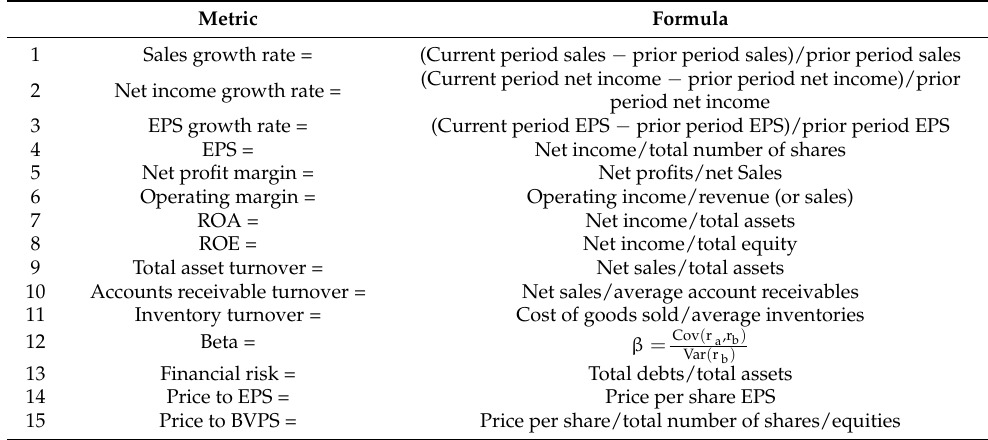
Table 1. All metrics